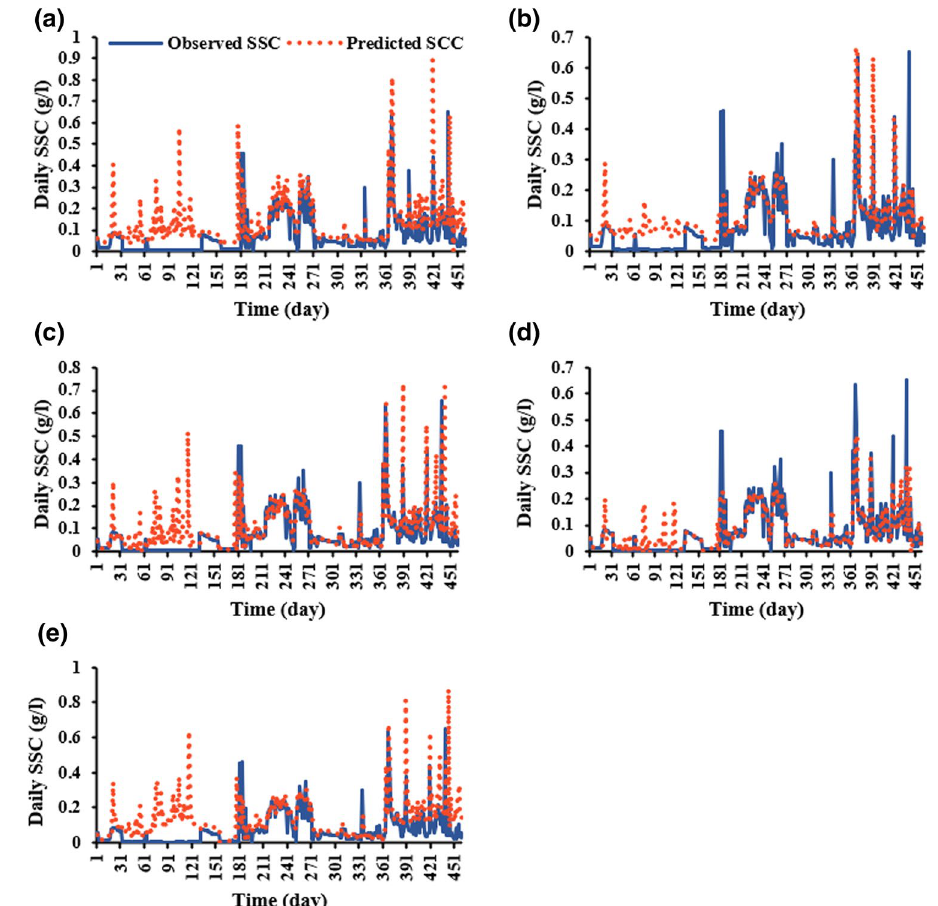
Fig. 8 Line diagram of devel- oped models a ANN, b WANN, c SVM, d WSVM and e MLR during the testing phase for Adityapur